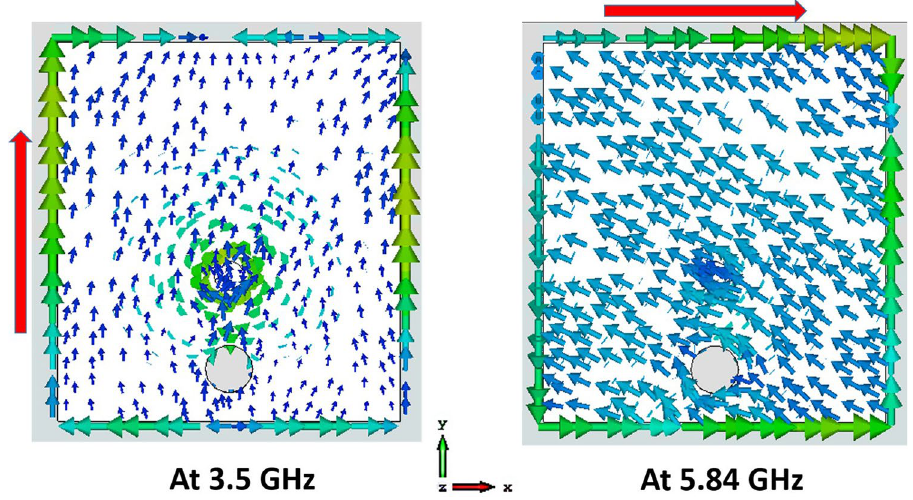
Figure 19. Schematic of surface current direction on the patch.